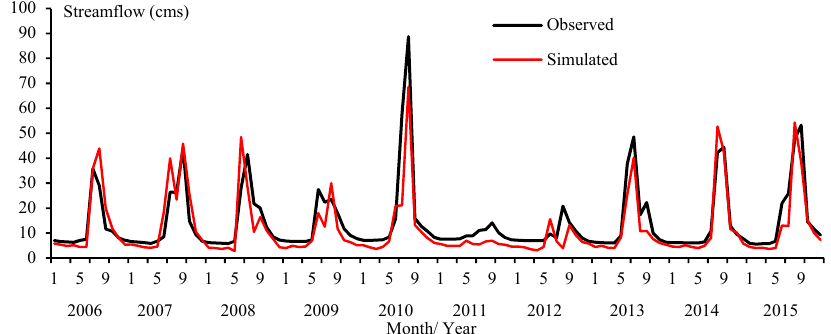
Figure 8. Soil and Water Assessment Tool (SWAT)-2M simulated monthly streamflow at the outlet of the middle reach.